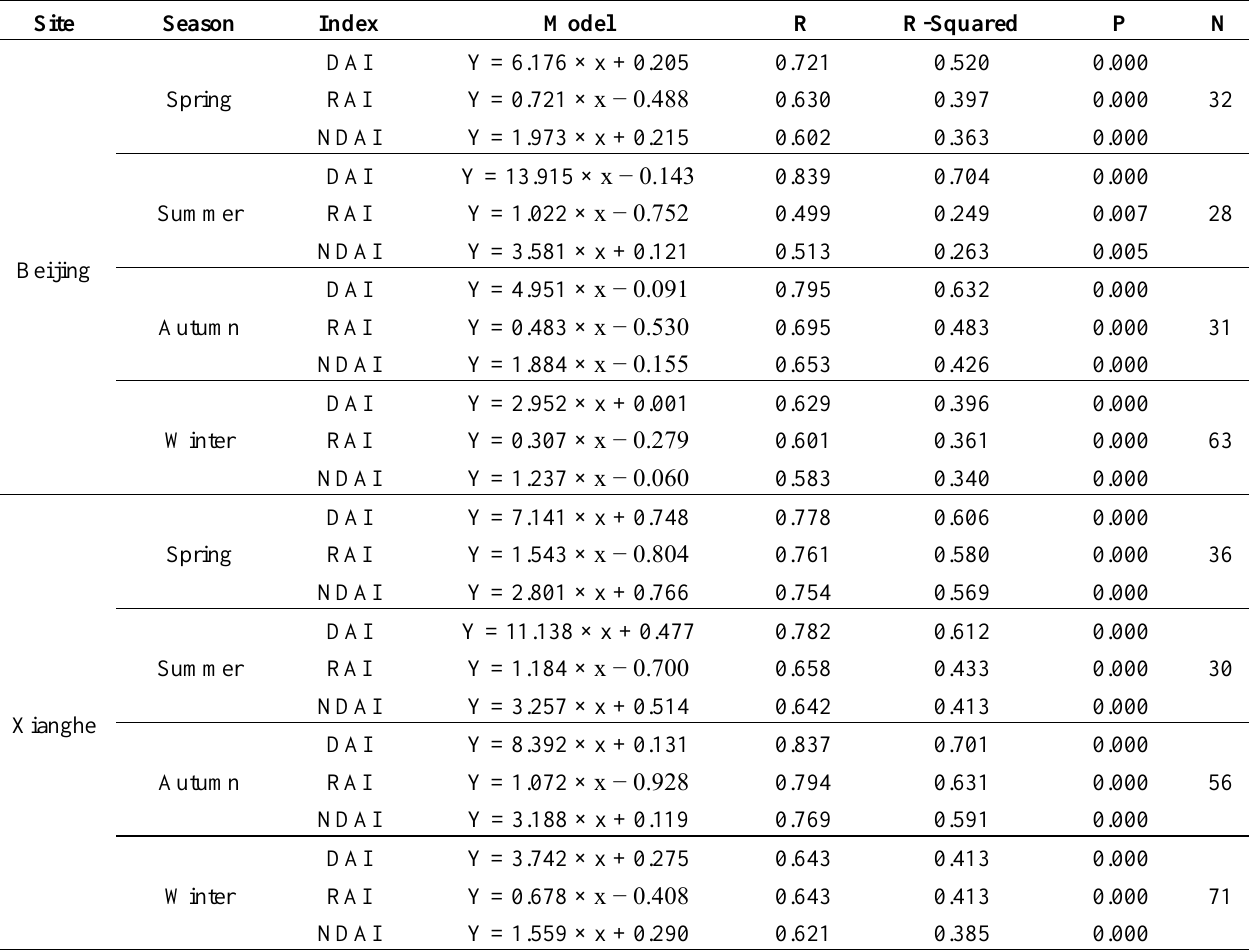
Table 5. Correlation coefficient between aerosol indices and in situ measured